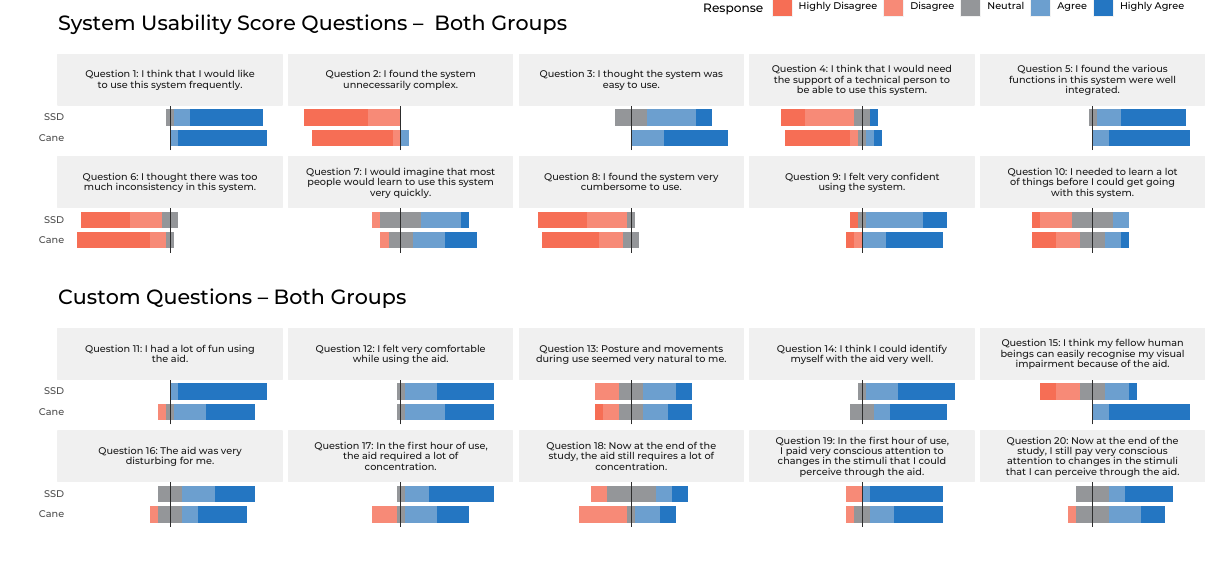
Figure 8. A summary of all Likert scale questionnaire items. The results are summarised for both groups (sighted/blind) and split per question according to SSD and